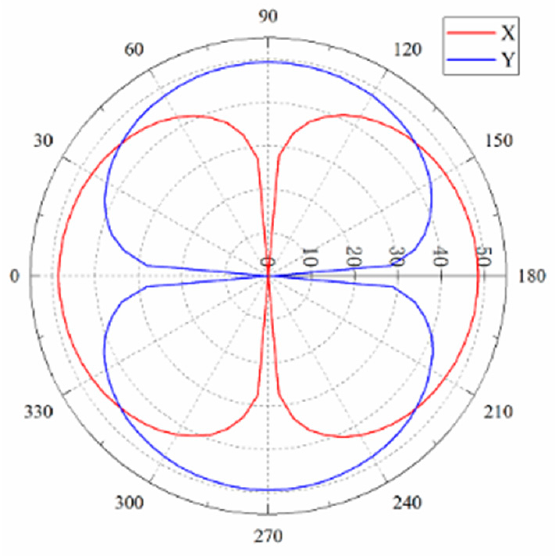
Figure 14. The “8” character directivity diagram.